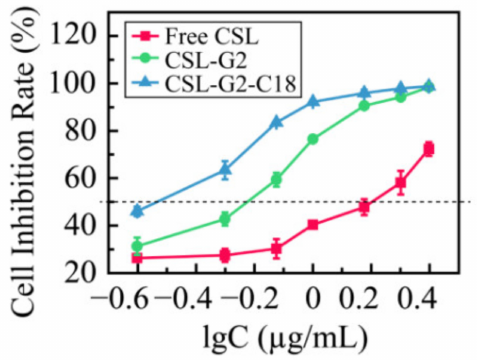
Figure 9. Cytotoxicity of CSL NPs to 4T1 cells after 48 h incubation ( n =